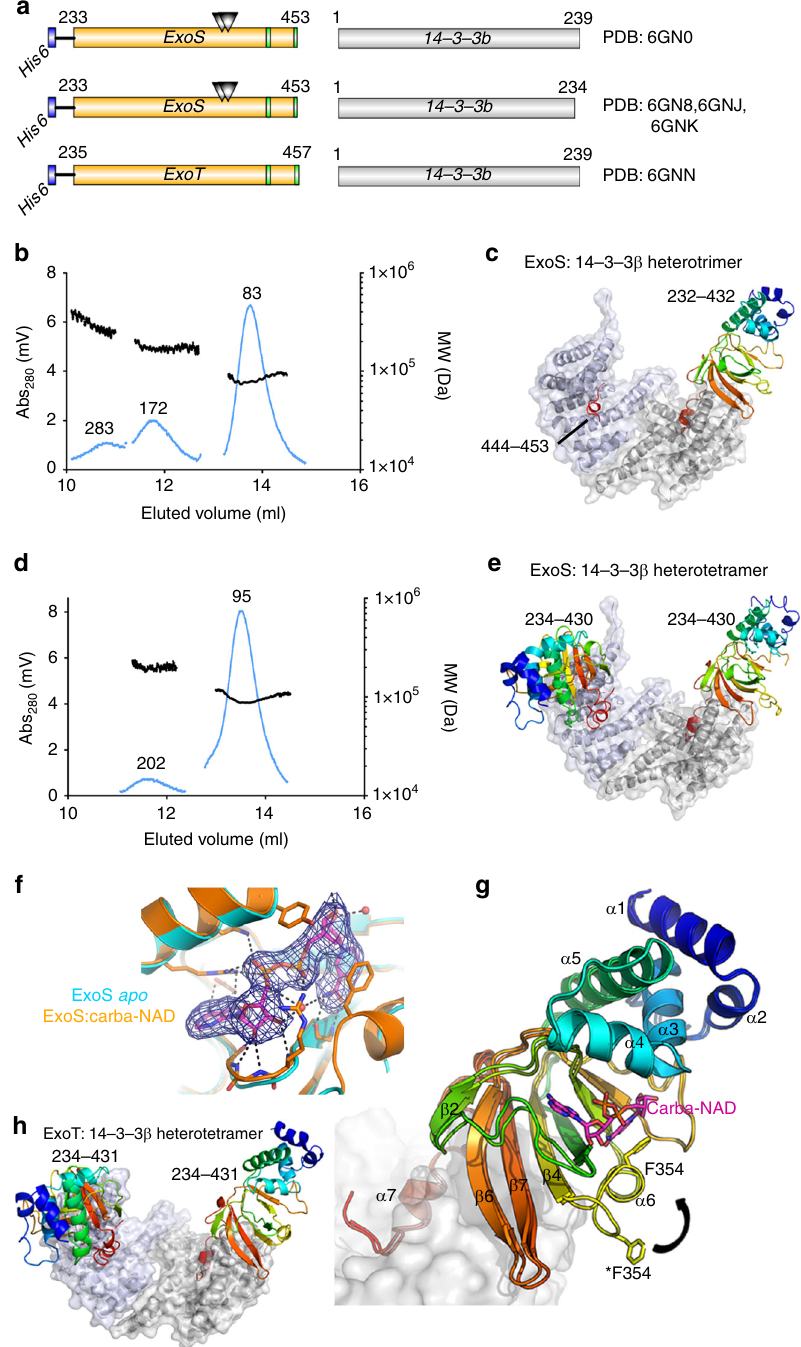
Fig. 1 Crystal structures of 14-3-3 β :ExoS and 14-3-3 β :ExoT complexes. a Schematic representation of co-expression constructs used for structure determination. Triangles represent the E379A,E381A double mutation. b , d SEC-RALS pro fi les of the heterotrimeric ( b ) and heterotetrameric ( d ) 14-3-3 β : ExoS complexes (main peaks). Estimated molecular weights are indicated. c , e Structures of the 14-3-3 β :ExoS heterotrimer ( c ) and heterotetramer ( e ). The 14-3-3 β dimer is shown in gray. Numbers in italics indicate the ExoS residues that were resolved in the electron density. f Detail of the electron density around carba-NAD in the active site of ExoS (2 F obs – F calc electron density map contoured at 1 σ (0.1073 eÅ − 3 )). g Comparison of the ExoS apo and carba- NAD structures. The loop containing F354 is in two different conformations, where the open conformation from the apo structure is marked with an asterisk. Secondary structural elements are numbered. h Structure of the 14-3-3 β :ExoT heterotetramer. c , e , g , h ExoS respectively ExoT are shown colored in a gradient from the N-terminus (blue) to the C-terminus (red) of the